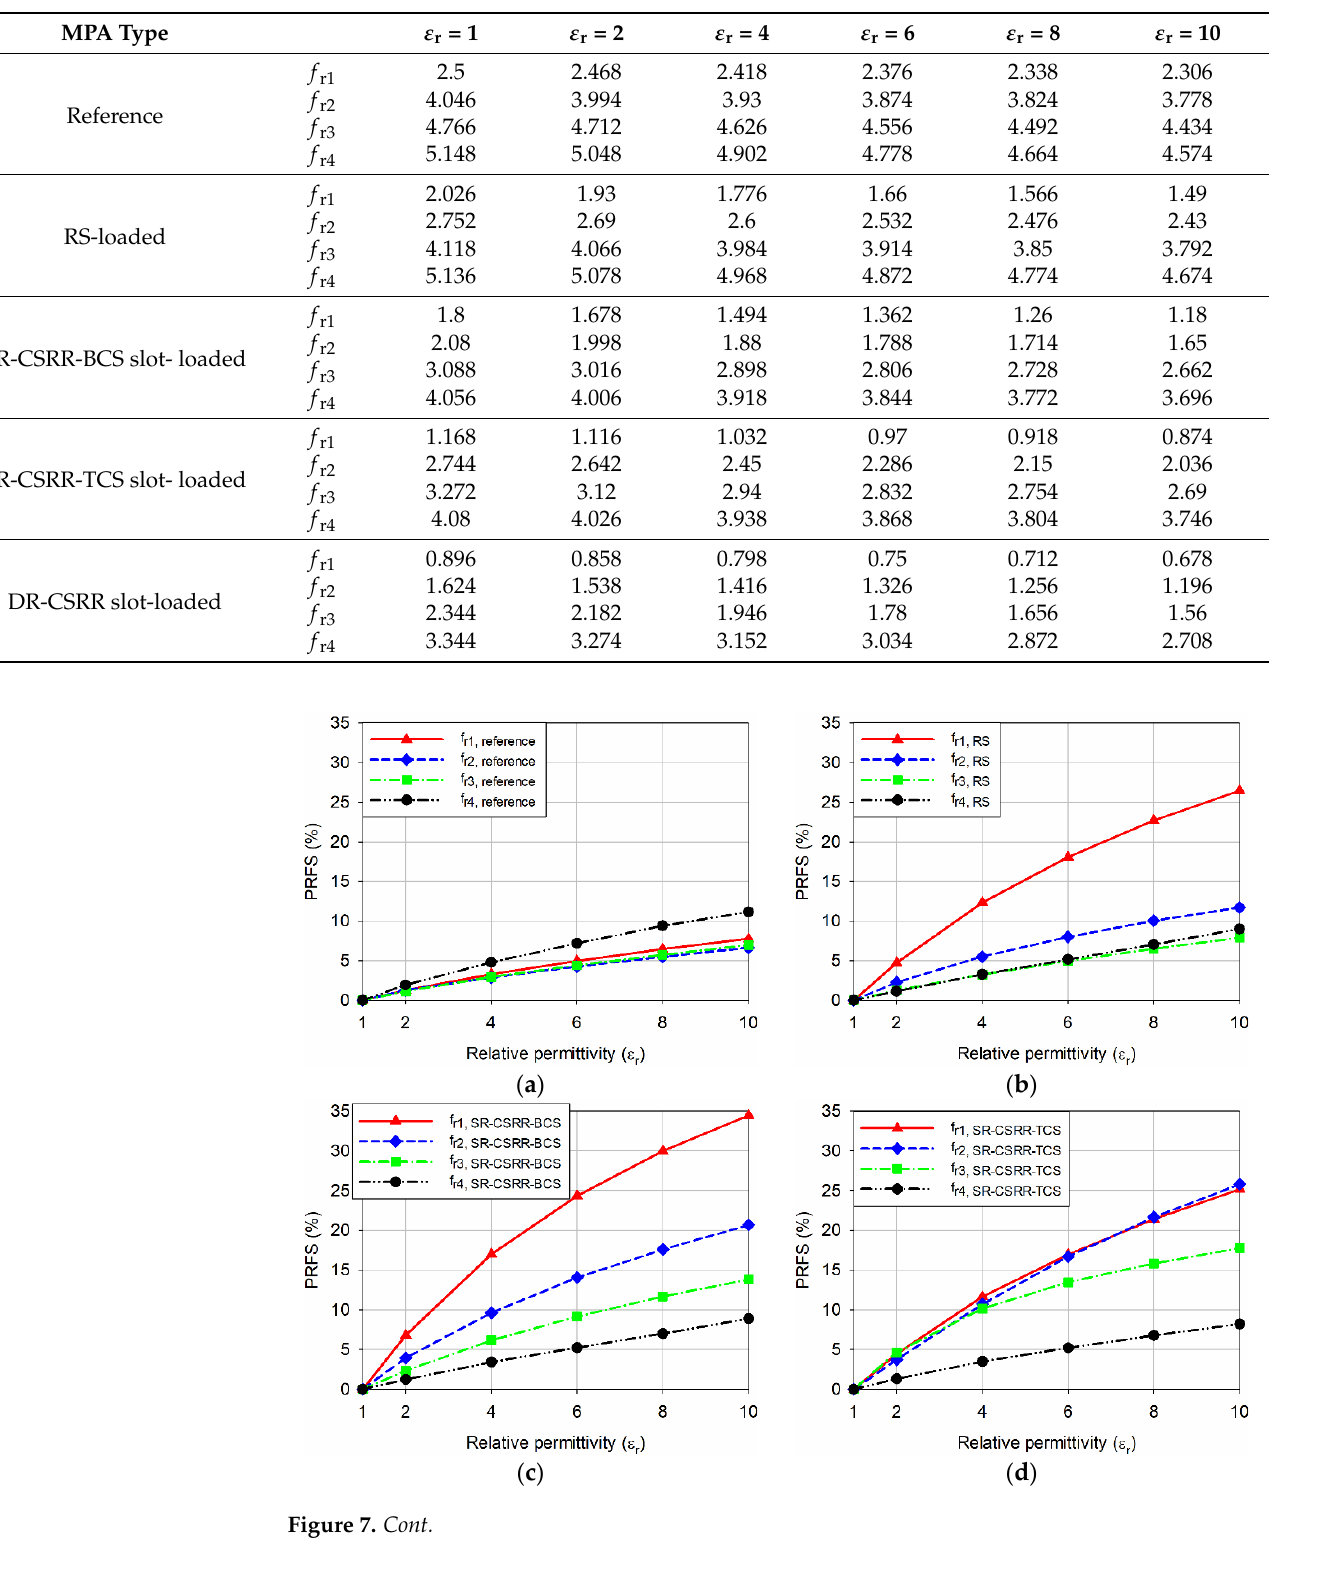
Table 2. Values of the first four resonant frequencies of the reference and four slot-loaded MPAs when varying the relative permittivity of the MUT superstrate from 1 to 10 (in gigahertz).